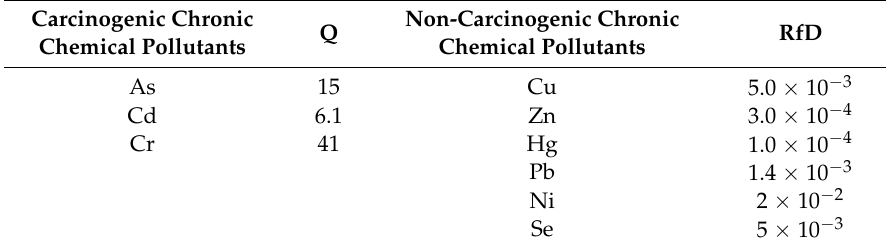
Table 2. The values of the q and RfD of model parameters.